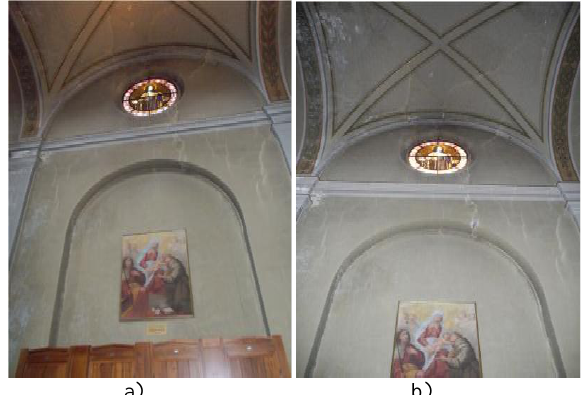
Figure 7. Comparison of the cracks present on the perimeter walls of the south aisle a) cracks related to the southern bay II and b) cracks of the southern bay II observed one year later.